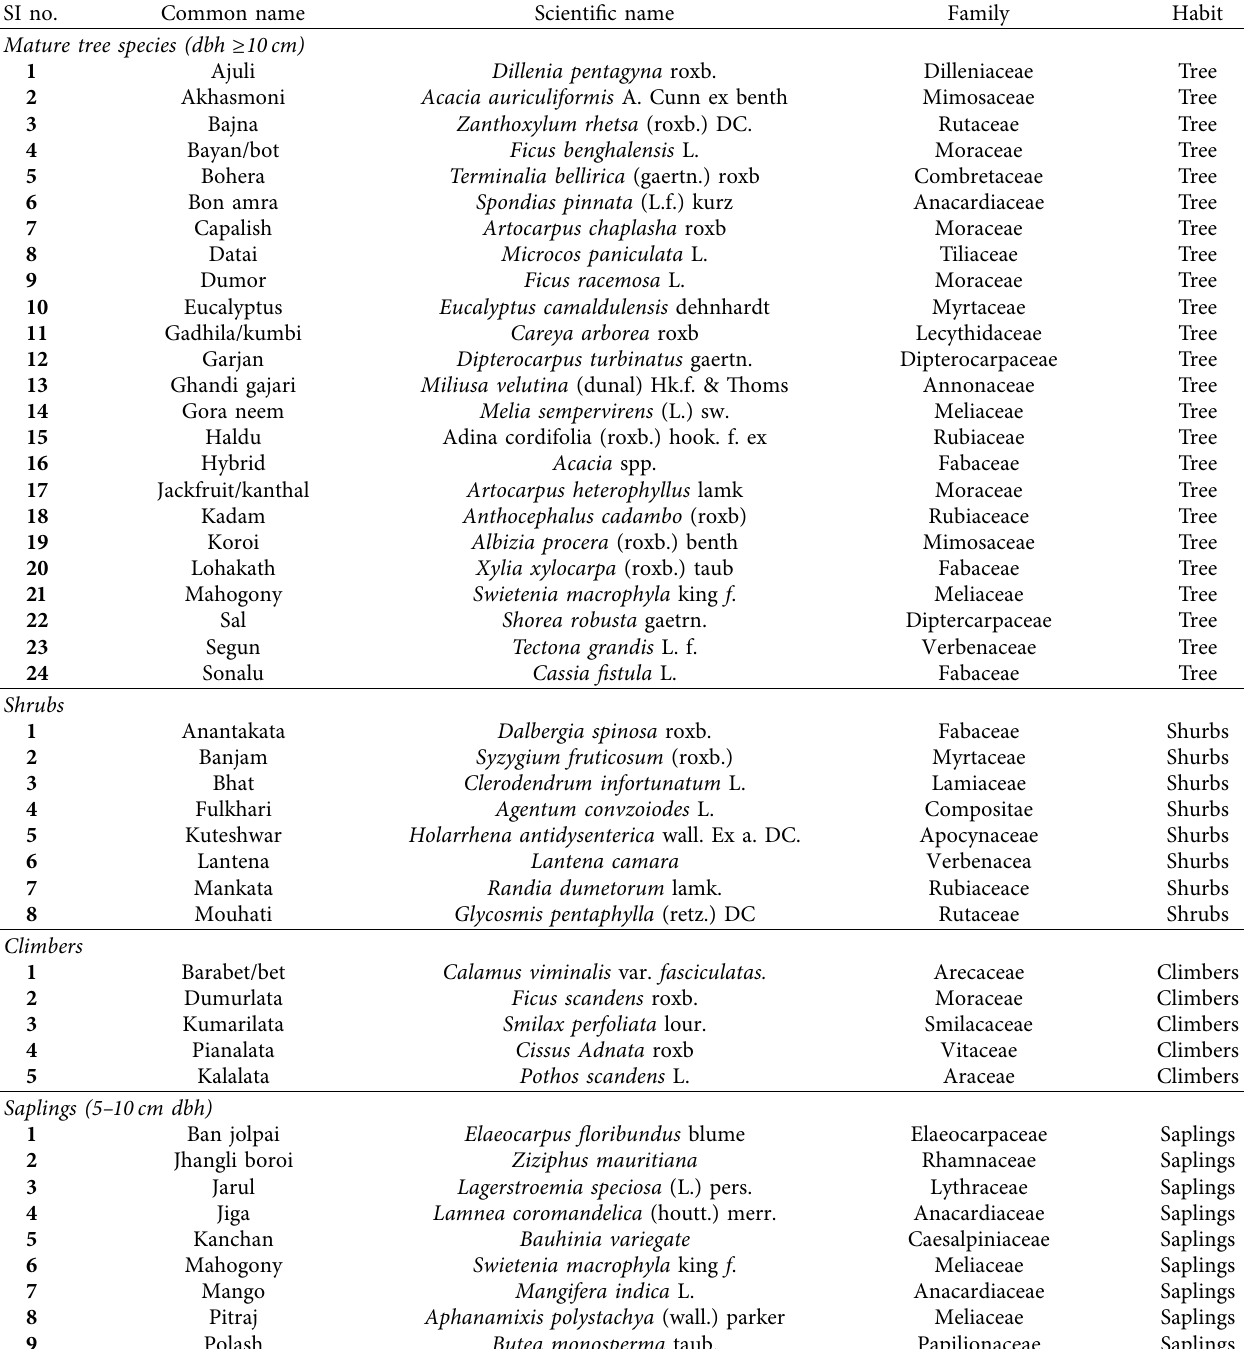
Table 4: List of recorded species in three distant sites arranged by common name, scientific name, and families with their habitats. SI